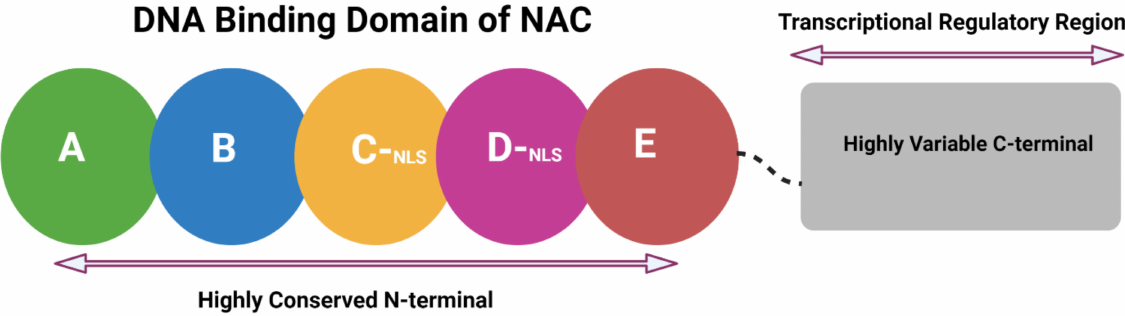
Figure 1. Schematic diagram of a typical NAC TF representing highly conserved N-terminal DNA binding domain (A–E subdomains) and highly variable C-terminal transcriptional regulatory region.